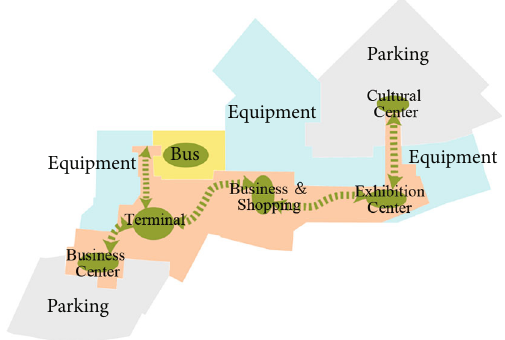
Figure 5: The underground walking system connects each functional node (source: self-created per the relevant